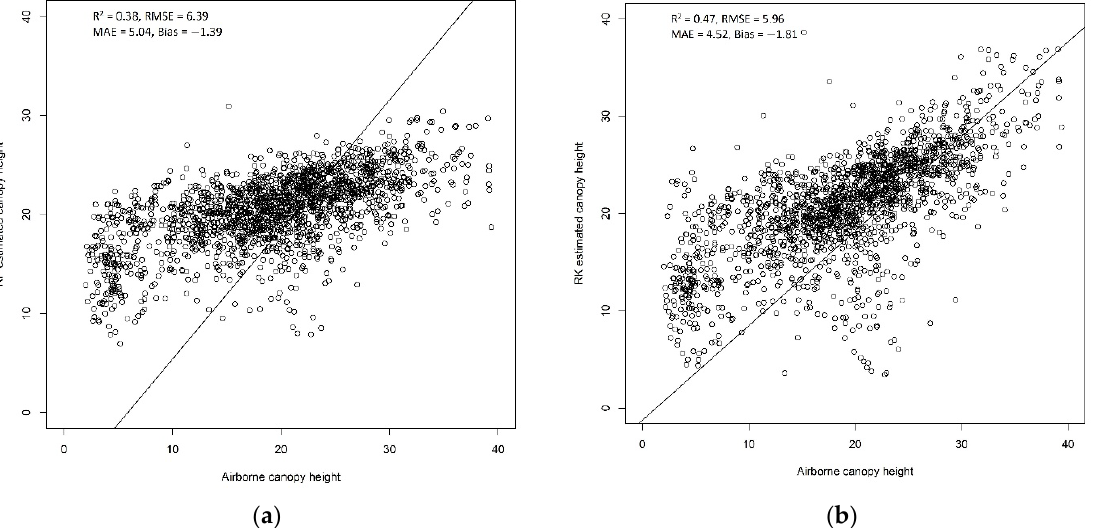
Figure 6. Scatterplot of airborne-lidar-derived and estimated canopy height at 30 m spatial resolution for ( a ) random forest and ( b ) regression kriging.